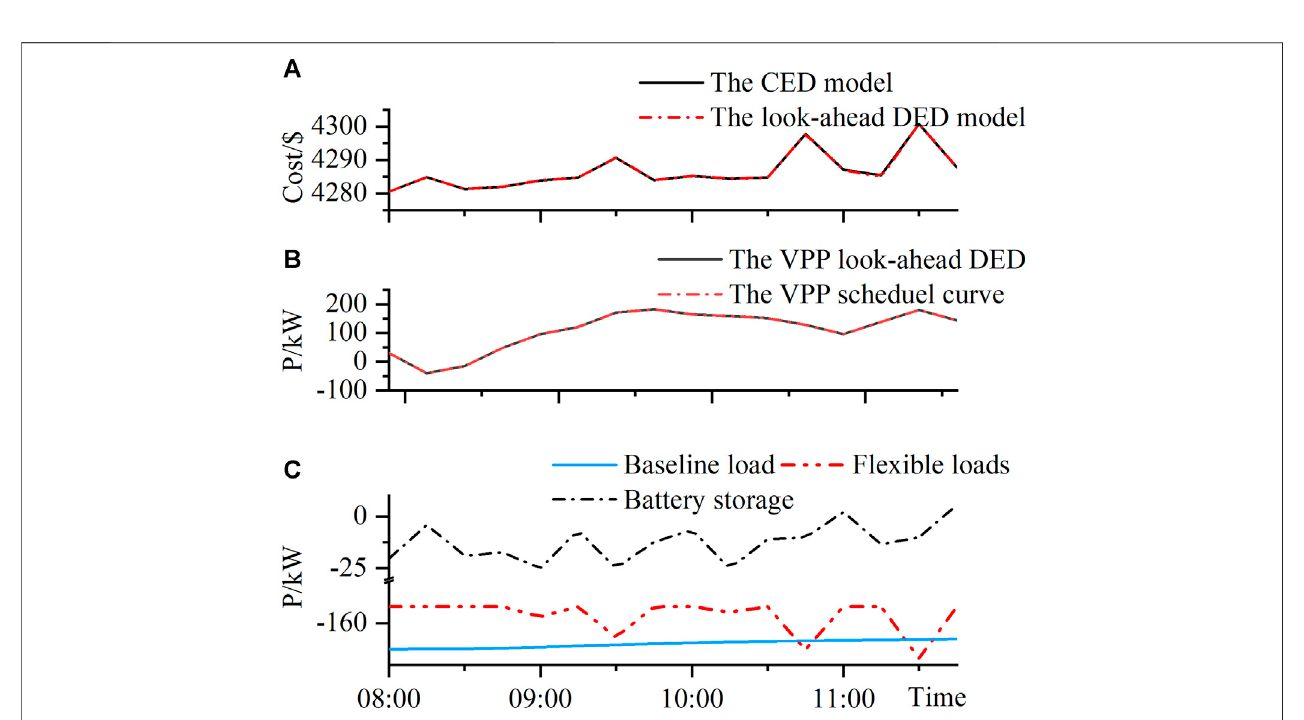
FIGURE 5 | The look-ahead DED performance analysis (A) Total cost (B) Tracking performance (C) Flexible loads and battery storage power.